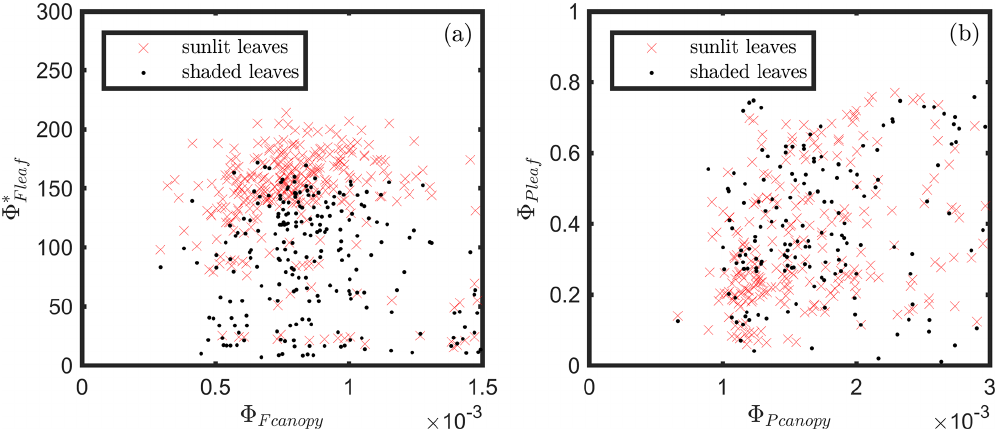
Figure A2. Relationships between leaf and canopy (cid:56) F (a) and leaf and canopy (cid:56) P (b) . (cid:56) F and GPP / APAR, respectively. (cid:56) F